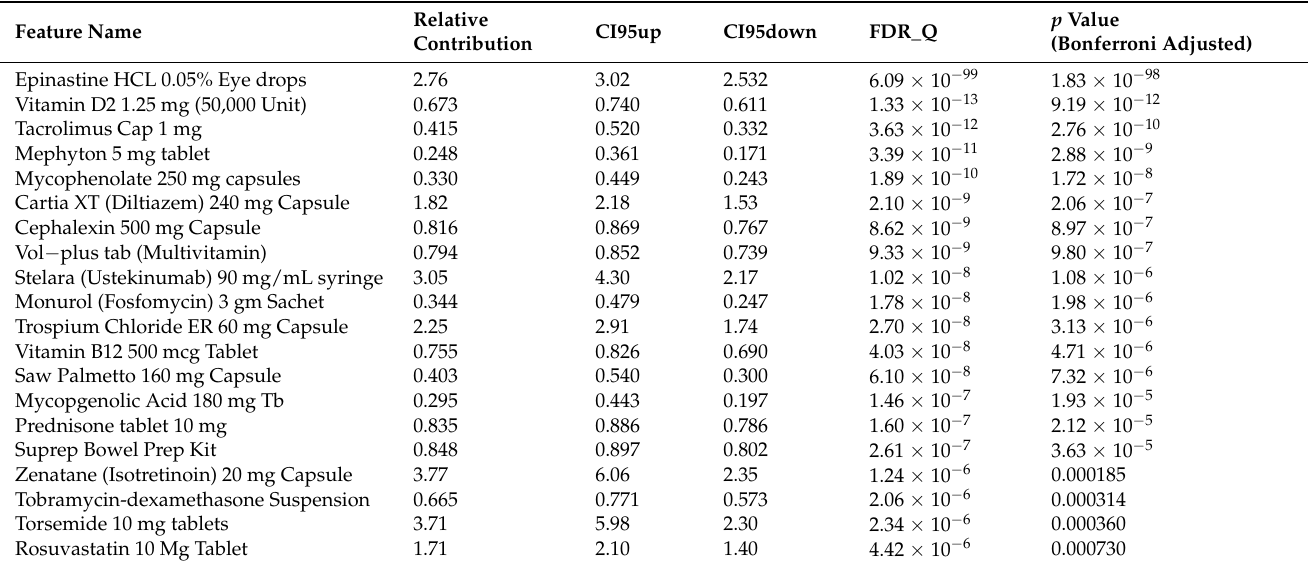
Table 3. Important medication use results identified by perturbation-based contribution analysis for SRE prediction.